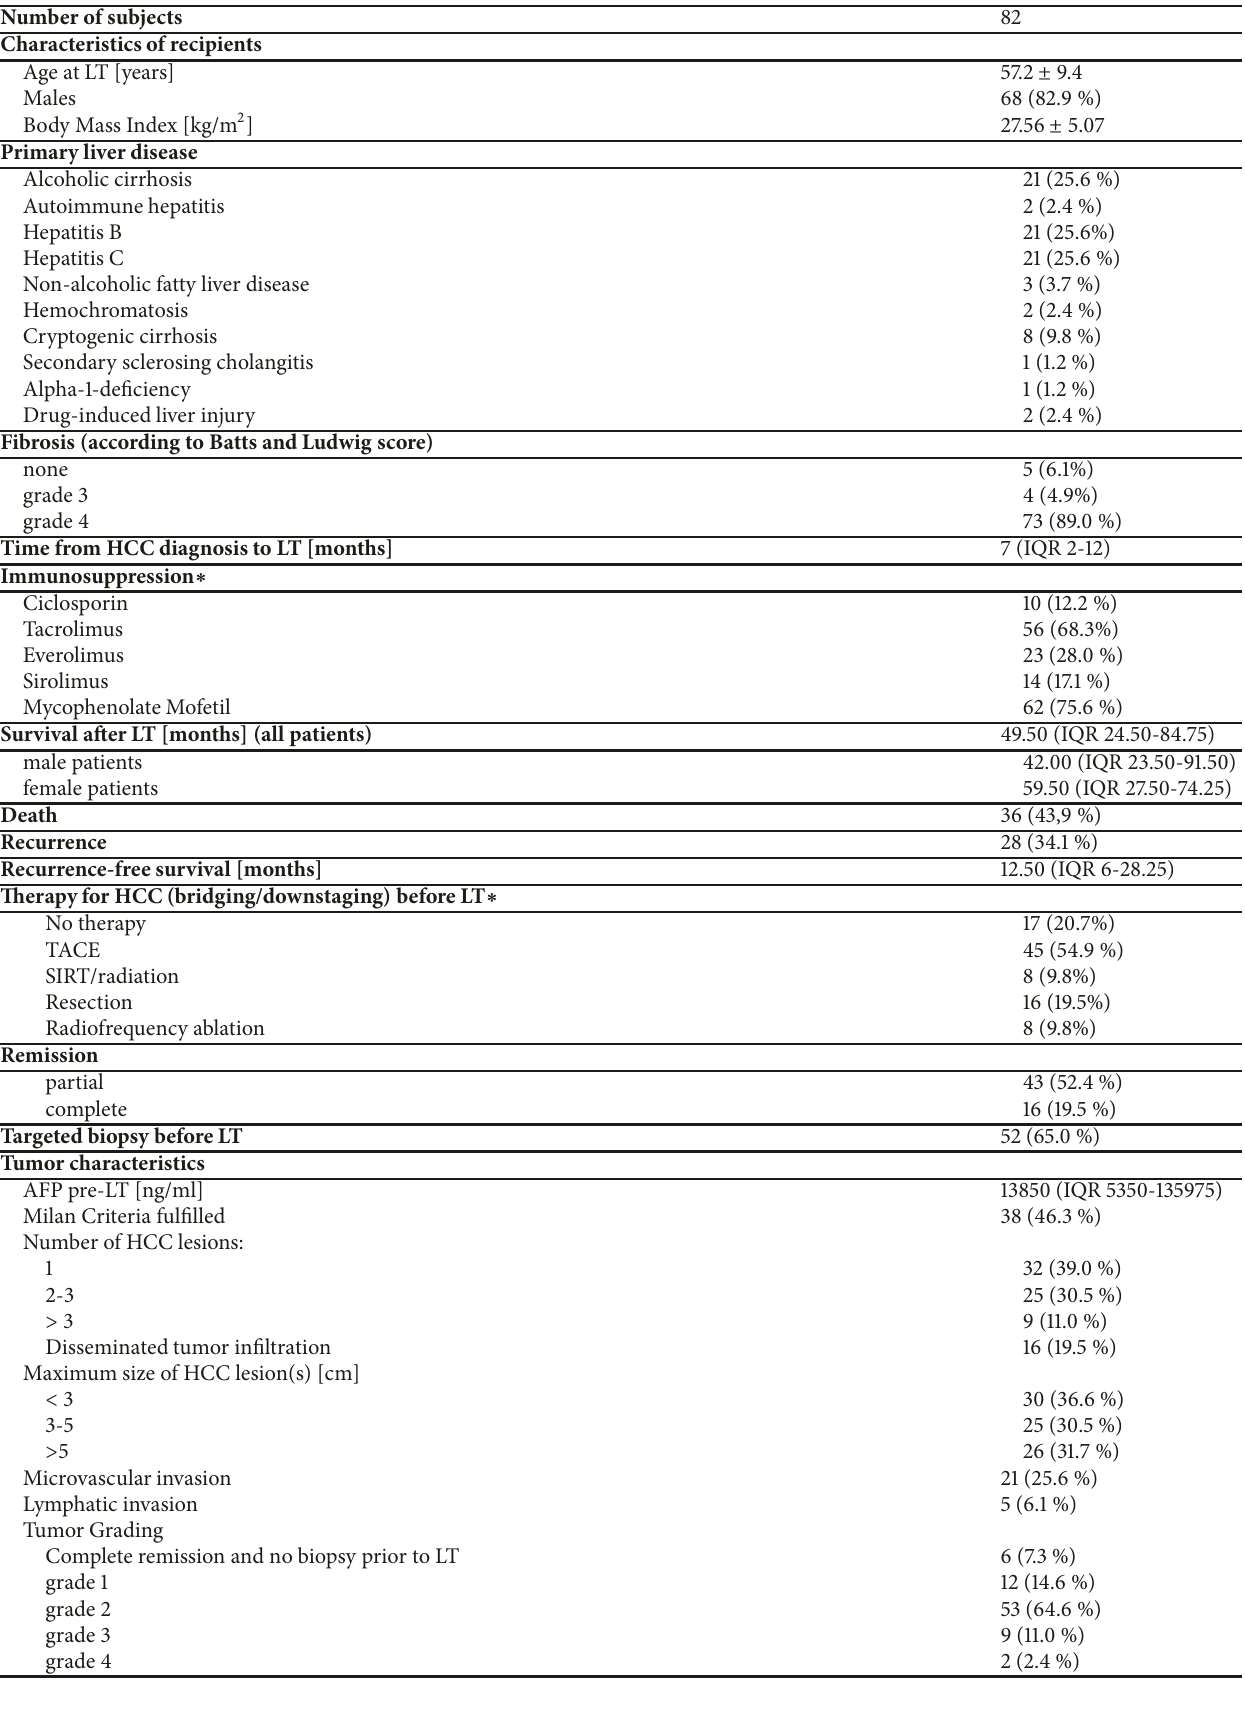
Table 1: Characteristics of recipients, tumors, and